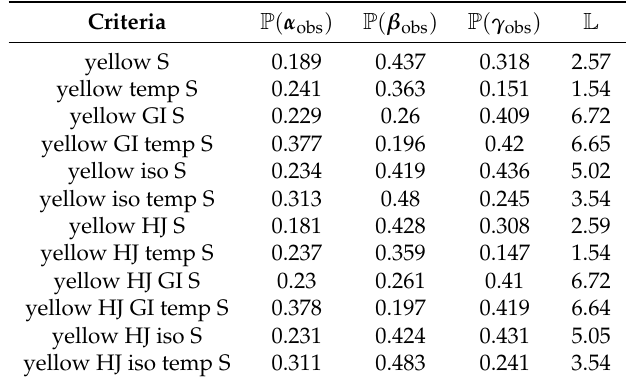
Table 4. Probabilities of different combinations of the habitability hypotheses discussed in the text. Here, yellow stands for the photosynthesis criterion, S the entropy criterion (both explained below Equation (1)), temp for the temperate zone, GI and iso for the terrestrial planet criterion with the giant impact and isolation production mechanisms, and HJ the hot Jupiter